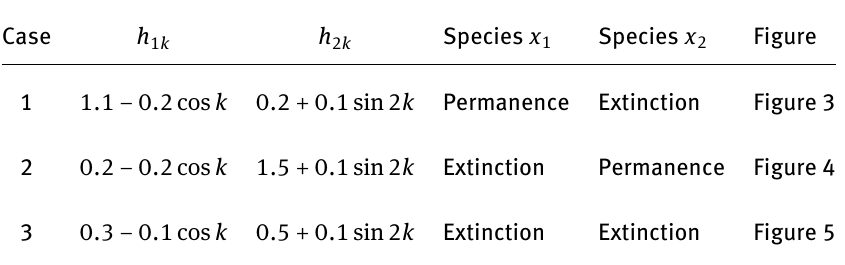
Table 2: Simulations of system